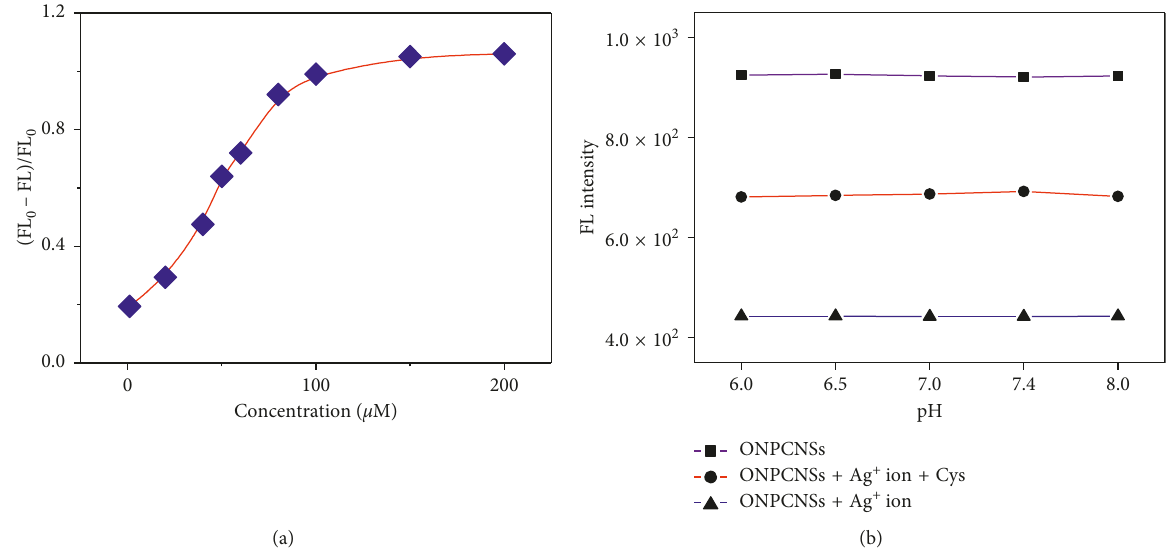
Figure 5: (a) FL quenching of the NRPCNSs in the presence of different concentrations of Ag + . (b) The FL intensity of the NRPCNSs at different pH values of PBS buffer solution in the absence (purple) or presence of Ag + (blue) or Ag + and Cys (red). The concentrations of Ag + and Cys are 80 µ M and 8 μ M,